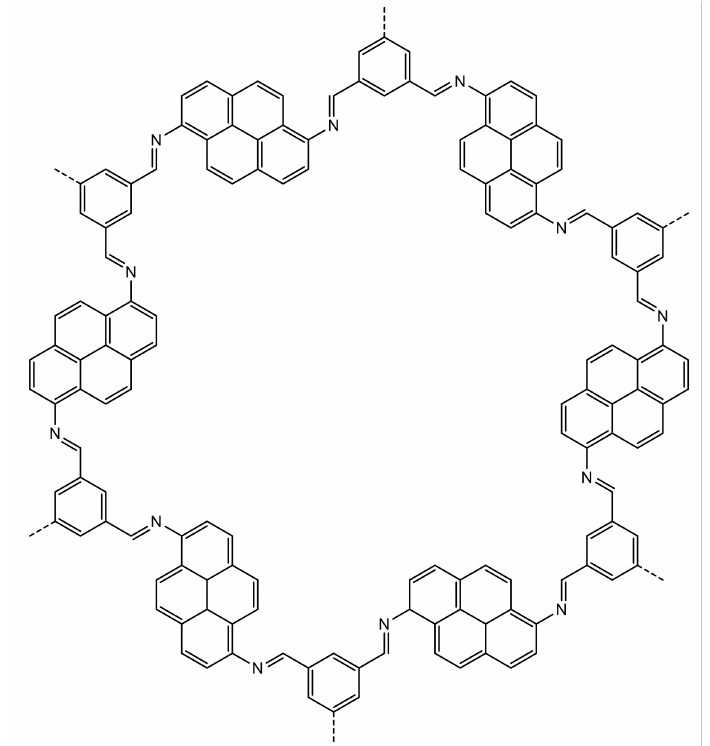
Figure 18. Structure of